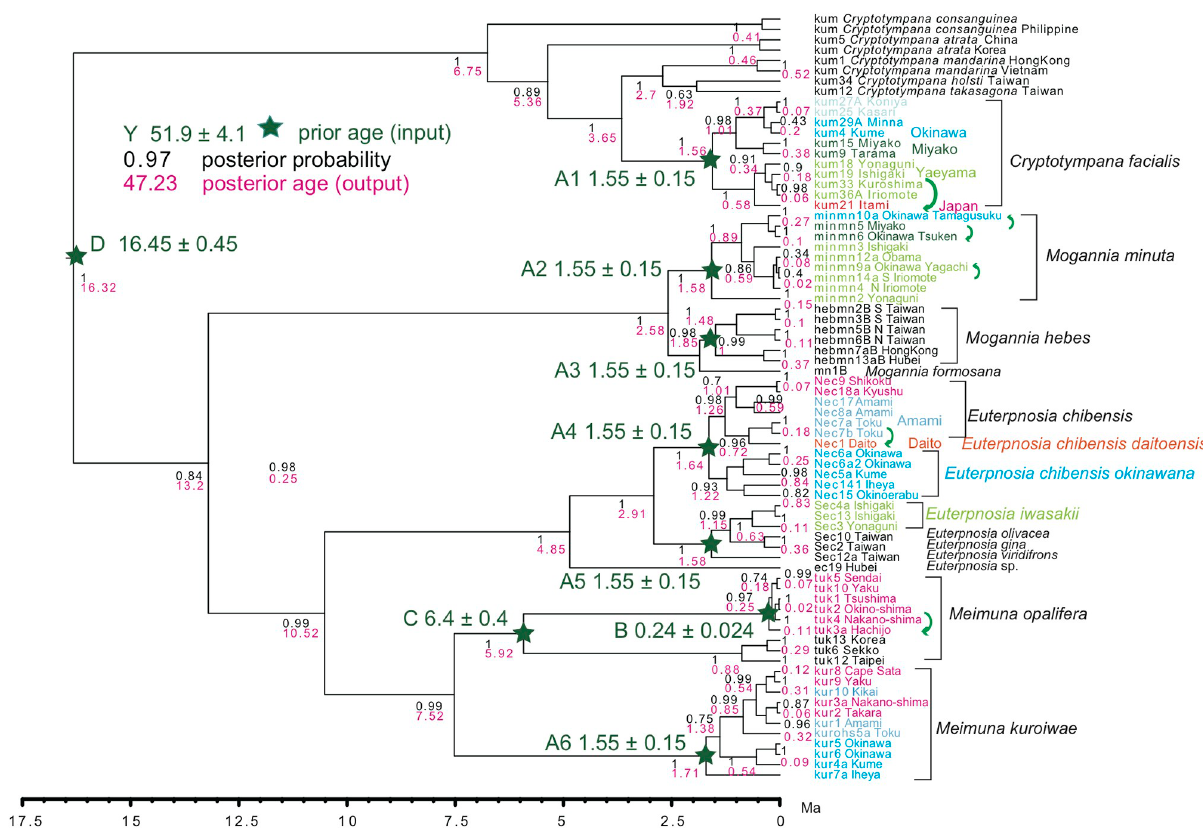
Fig 6. BI tree for Cryptotympana , Euterpnosia , Mogannia , and Meimuna . Vicariantly speciated island populations are shown by different colored text labels. Calibration points and dates are shown by green stars and corresponding large font green text labels. Black numbers on each node: posterior probability, red numbers: age (in Ma). The green curved arrows depict dispersal after the vicariance.